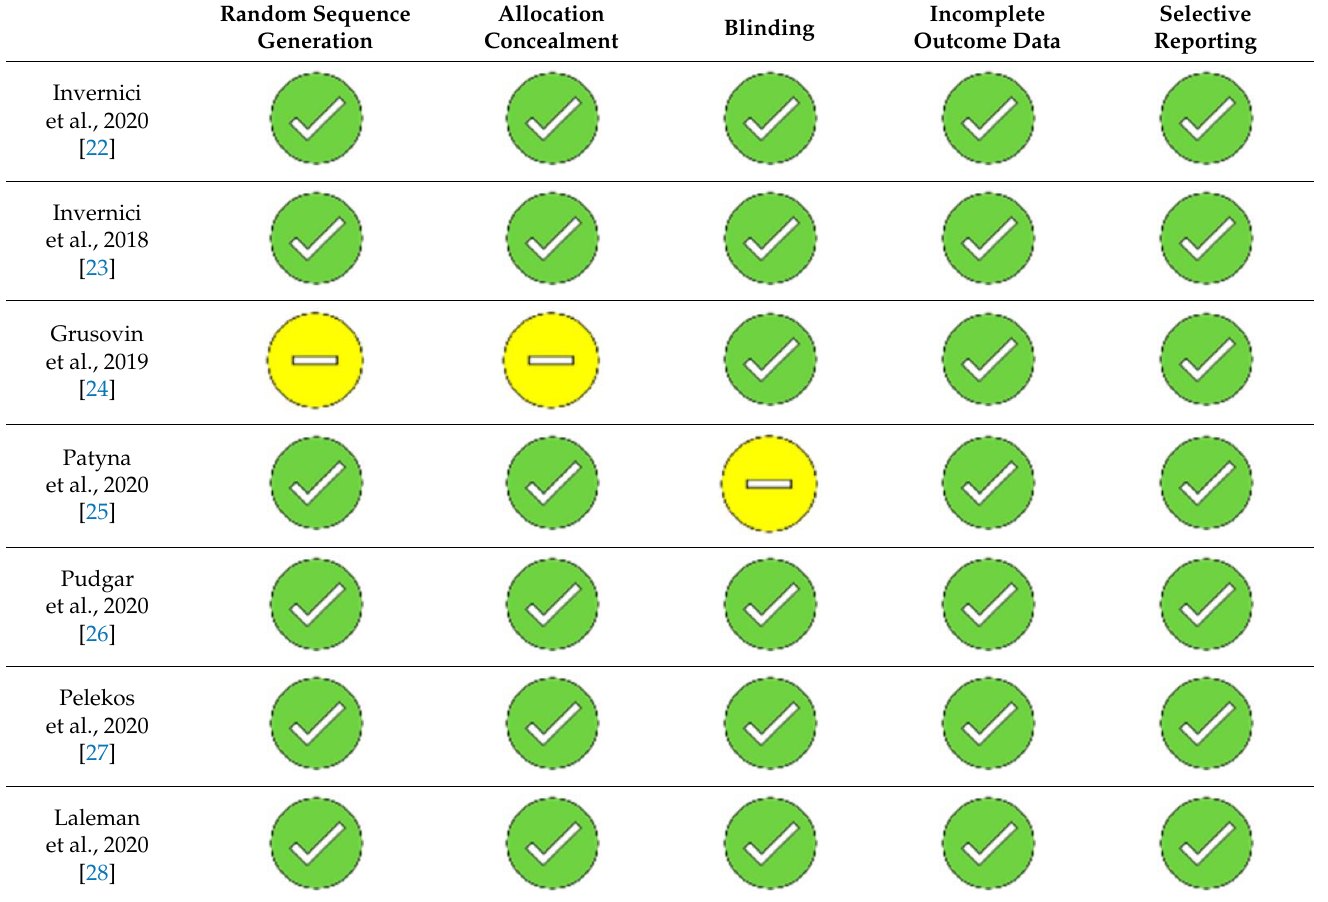
Table 3. Outcomes of the included studies.